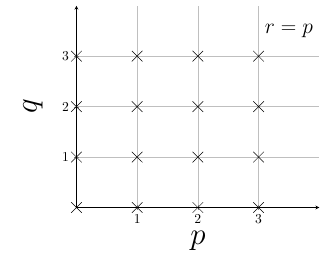
Figure 6. Scalar tower.